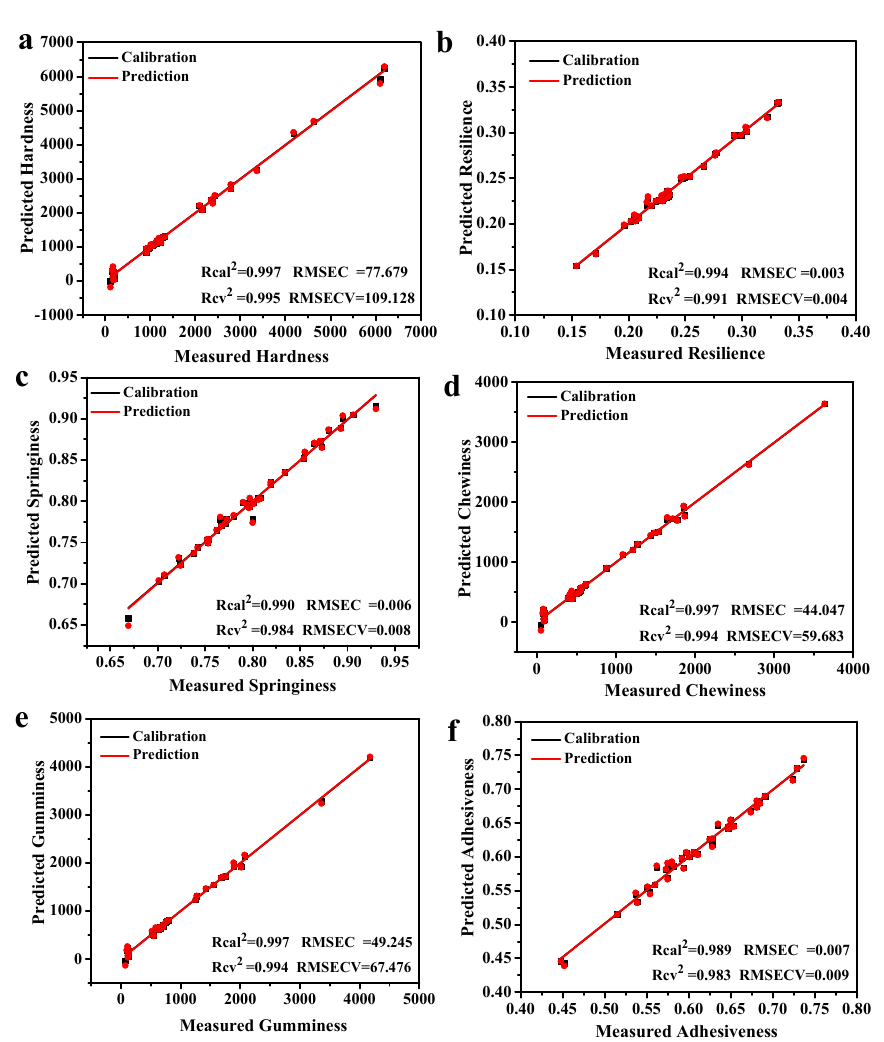
Figure 8. ( a ) Hardness, ( b ) resilience, ( c ) springiness, ( d ) chewiness, ( e ) gumminess, ( f ) adhesiveness in Spanish mackerel samples using LF-NMR data combined with PLS regression.